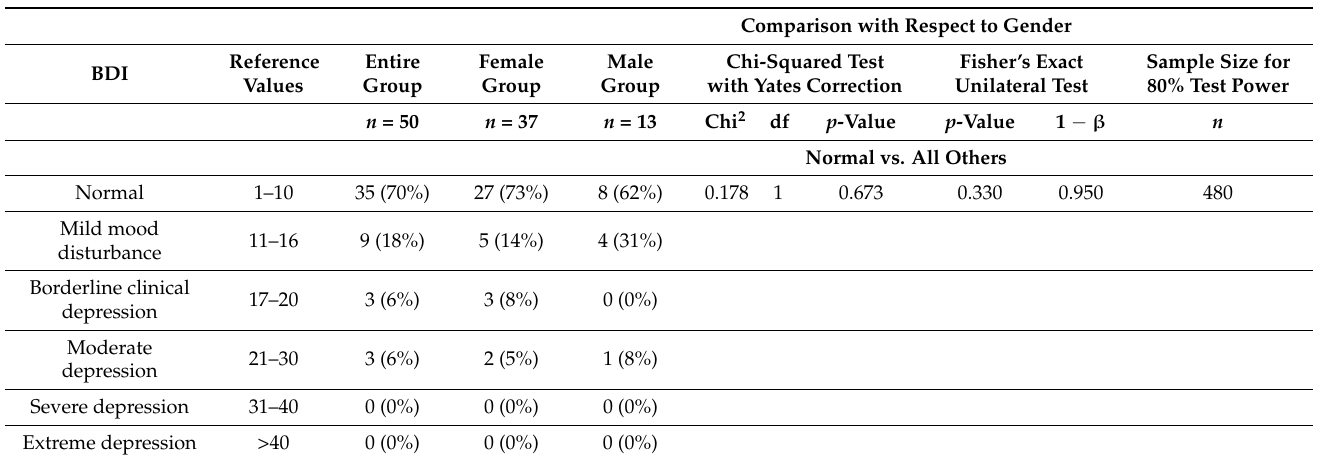
Table 3. Levels of depression with respect to the BDI. Numerical and percentage values are given for the study group ( n = 50) and for the group of females ( n = 37) and males ( n = 13).